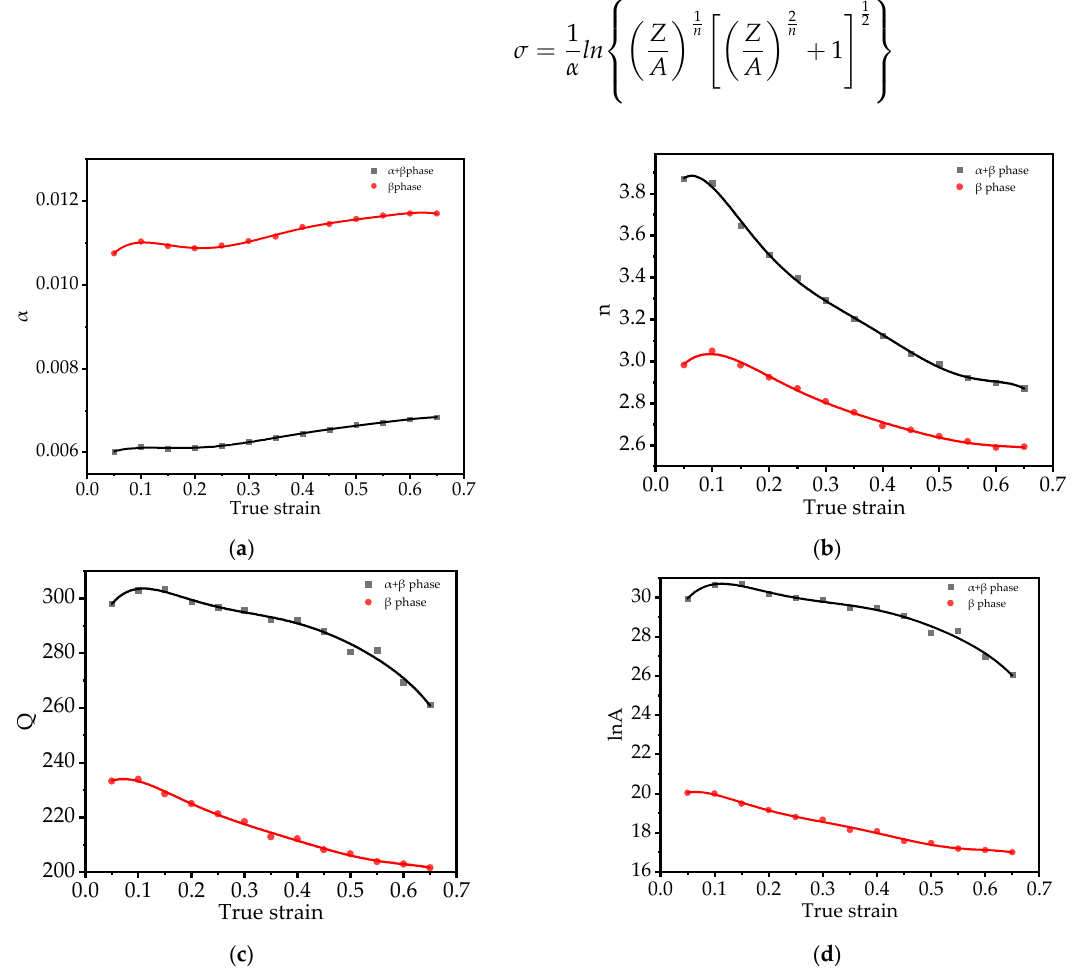
Figure 4. Variations in the ( a ) ln A , ( b ) n , ( c ) Q , ( d ) α values with strain for the Ti − 65541 alloy. Table 2. Polynomial fit coefficients of α , n, Q , and ln A for the Ti − 65541 alloy of the α + β phase.